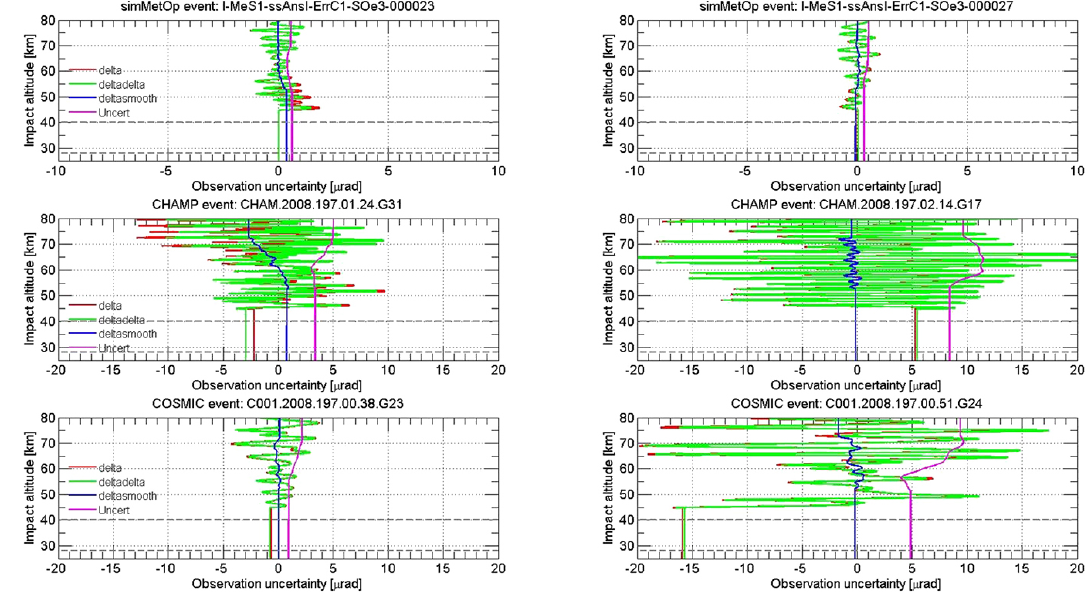
Figure 4. Observation uncertainty and key intermediate variables for six representative RO events, two simMetOp events (top), two CHAMP events (middle), and two COSMIC events (bottom) from 15 July 2008. “delta” is the difference profile of the RO ionosphere-corrected bending angle to the co-located ECMWF forecast profile used as a reference, “deltadelta” is the delta-difference profile after subtracting a smoothed profile “deltasmooth” from the difference profile “delta”, and “Uncert” is the resulting observation uncertainty estimate; for detailed description see Sect. 2.2.